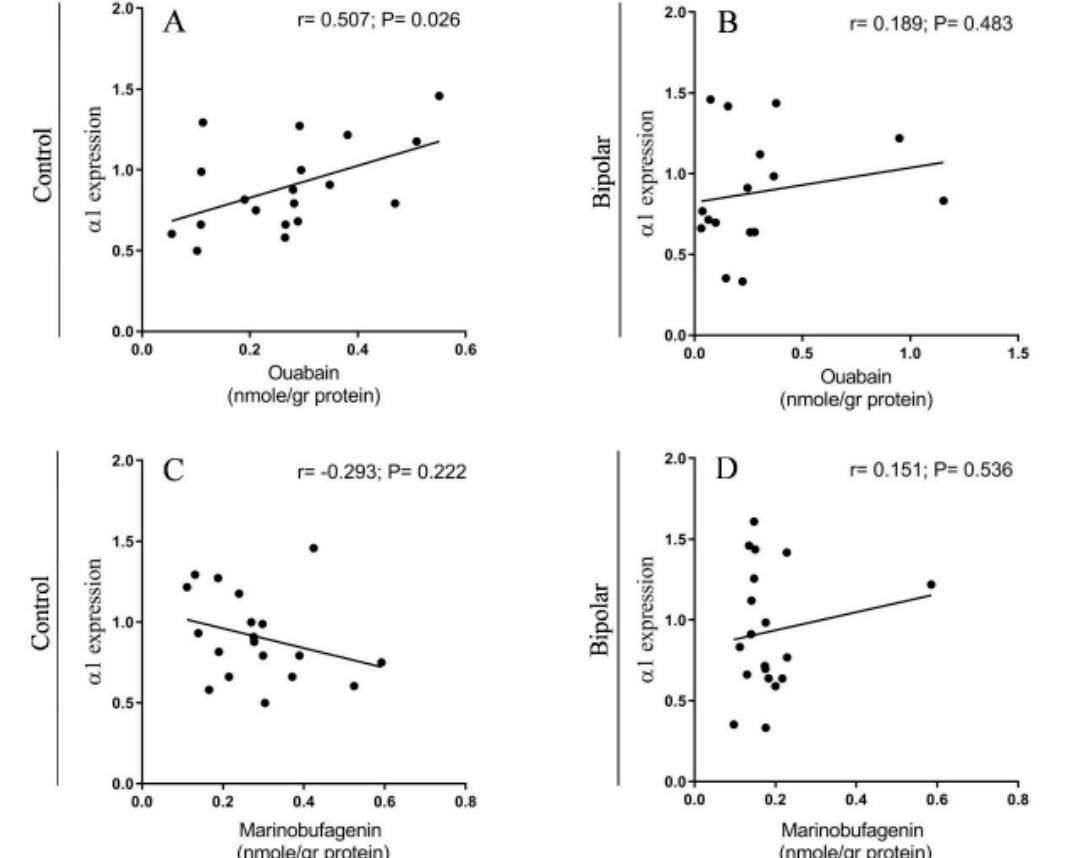
Figure 8. The correlation between the α 1 isoform levels and endogenous OUA and MBG immuno-reactivity in the PFC of BD patients and controls. The levels of the α 1 isoform of the Na + , K + -ATPase (Figure 1) and OUA and MBG immuno-reactivity (Figure 3) in BD patients ( C – D ) and controls ( A – B ) were correlated. The Pearson correlation coefficient ( r ) and the p value (two tailed) were calculated by using correlation analysis (GraphPad Prism v 8.3.1).